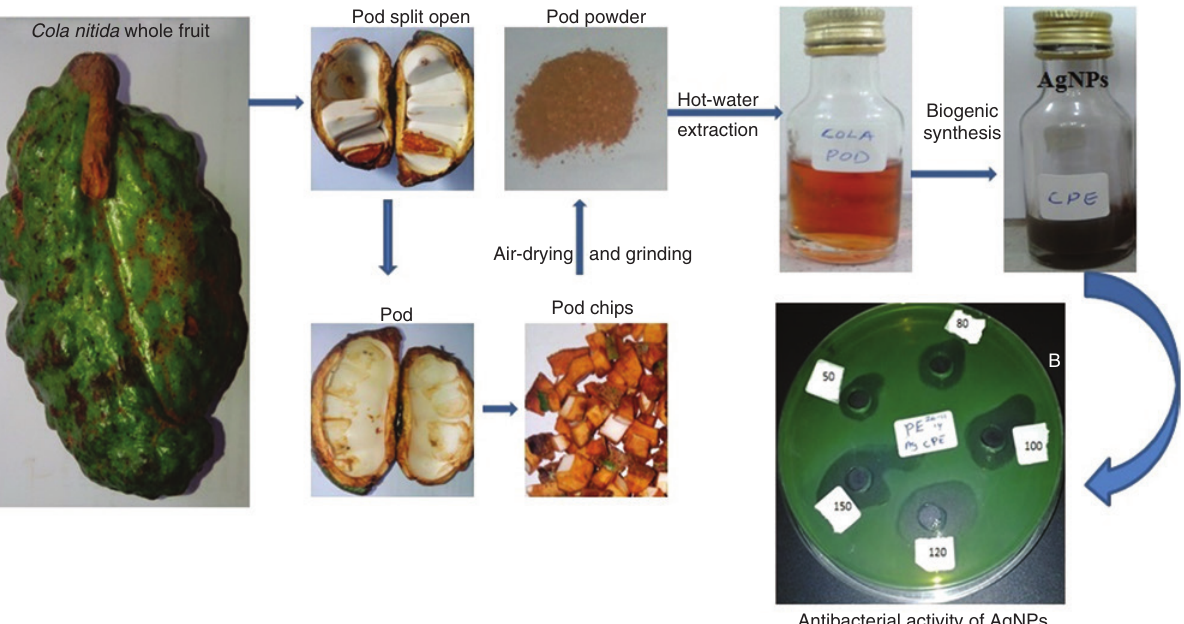
Cola nitida whole fruit